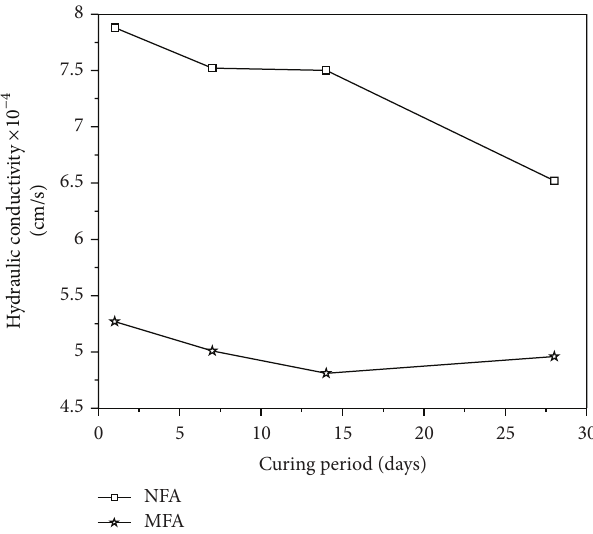
Figure 8: Variation of hydraulic conductivity with curing